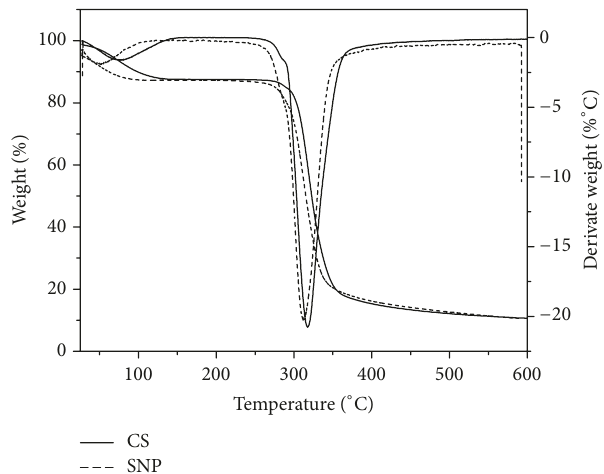
Figure 3: X-ray diffraction patterns for cassava starch (CS) and starch nanoparticles (SNP).